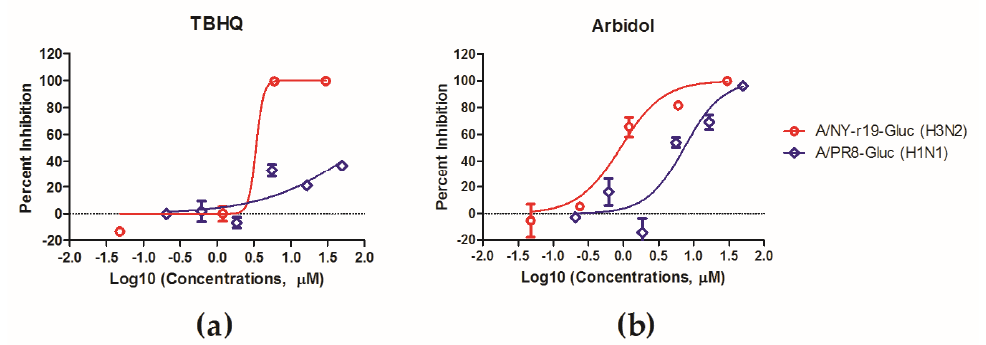
Figure 5. In vitro antiviral determination using NY-r19–Gluc virus as a tool. MDCK cells were infected with the NY-r19–Gluc virus at a MOI of 0.1 in presence of ( a ) TBHQ and ( b ) arbidol, respectively. Infections by PR8-Gluc were performed in parallel as a control. Virus infections were monitored by Gluc examination, and the inhibitory effects were analyzed using GraphPad Prism 5.